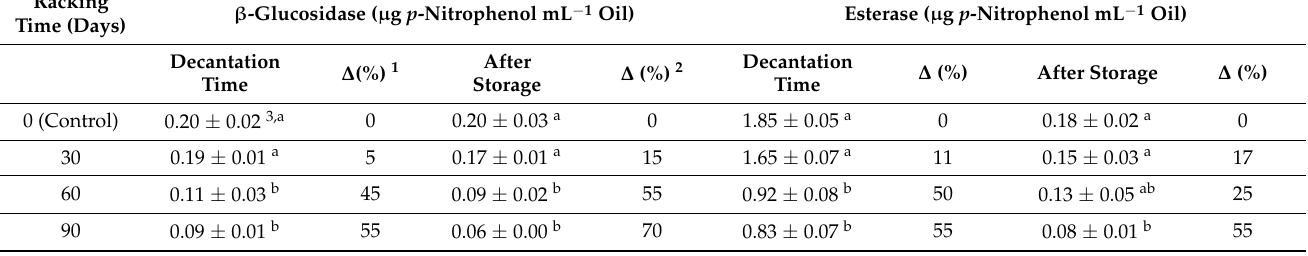
Table 2. Endogenous oleuropeinolytic activity of Coratina monocultivar EVOO evaluated during the decantation time and after seven months of storage.